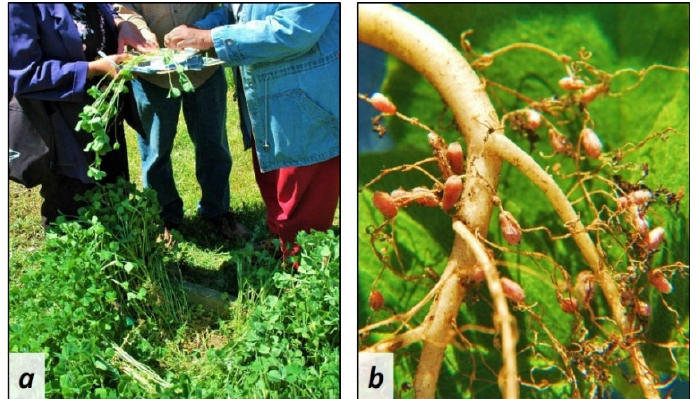
Figure 2. Observing Indicators of Legume Nitrogen Fixation in Farmer Field School